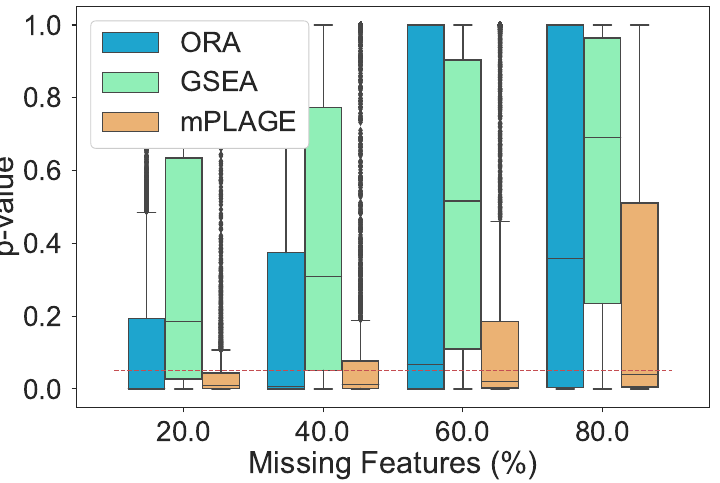
Figure 4. Resulting p -values from removing features from significantly changing pathways. The percentage of features randomly removed from the pathways increases from 20% to 80% and ORA, GSEA, and mPLAGE are compared. The red dashed line indicates a p -value threshold of 0.05. The results show that mPLAGE performs better, returning lower p -values compared to the alternatives, even in the presence of a large number of missing features.